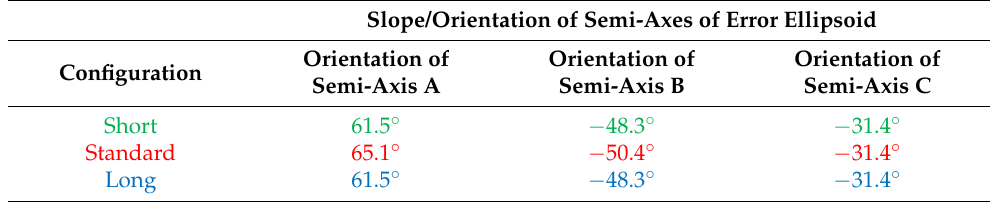
Table 3. Error ellipsoid orientation for all 3 configurations—short, standard and